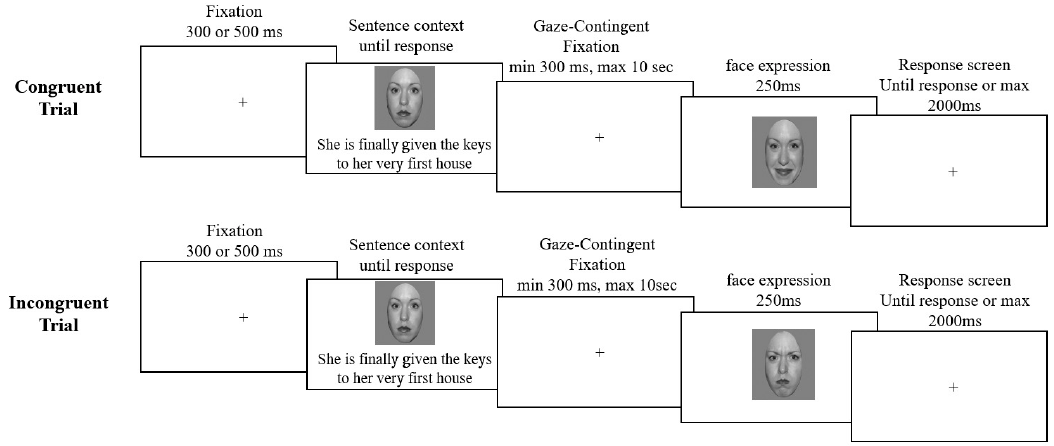
Figure 1. Exemplars of congruent and incongruent trials with angry and happy expressions (trials progression from left to right). In both tasks, a fixation cross was presented for 300 ms or 500 ms (jittered by 0–100 ms), followed by the presentation of a face with a neutral expression and a